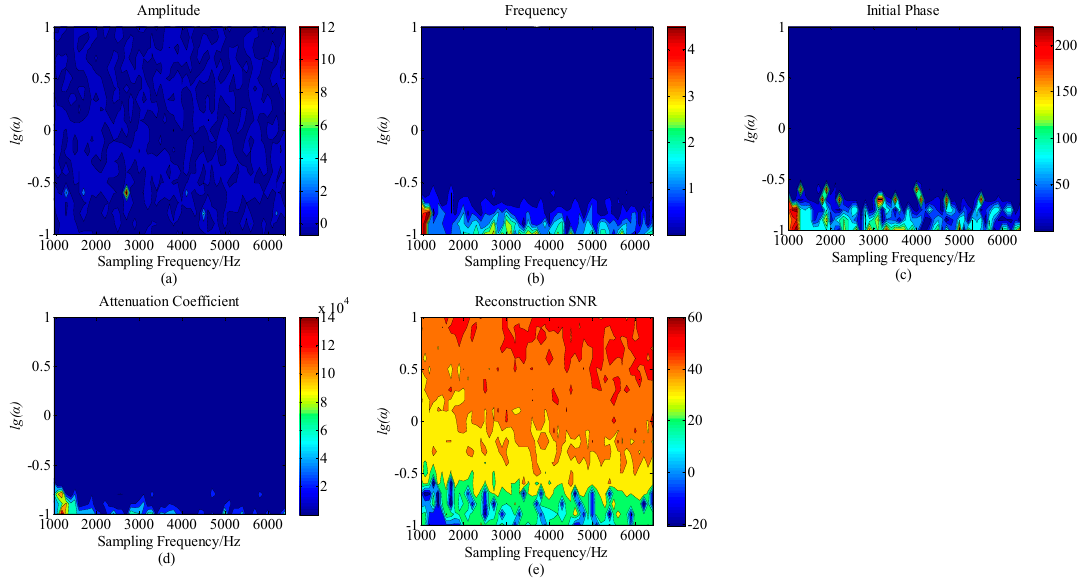
Figure 1. The reconstruction SNR and relative error of parameters with different sampling frequency and number of cycles: ( a ) The relative error of amplitude; ( b ) The relative error of frequency; ( c ) The relative error of initial phase; ( d ) The relative error of damping ratio; ( e ) SNR rec of the test signal.